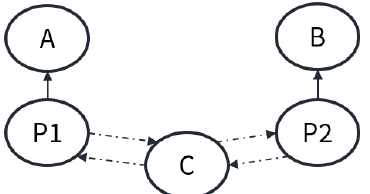
Figure 7. Diagram of the system block from Figure